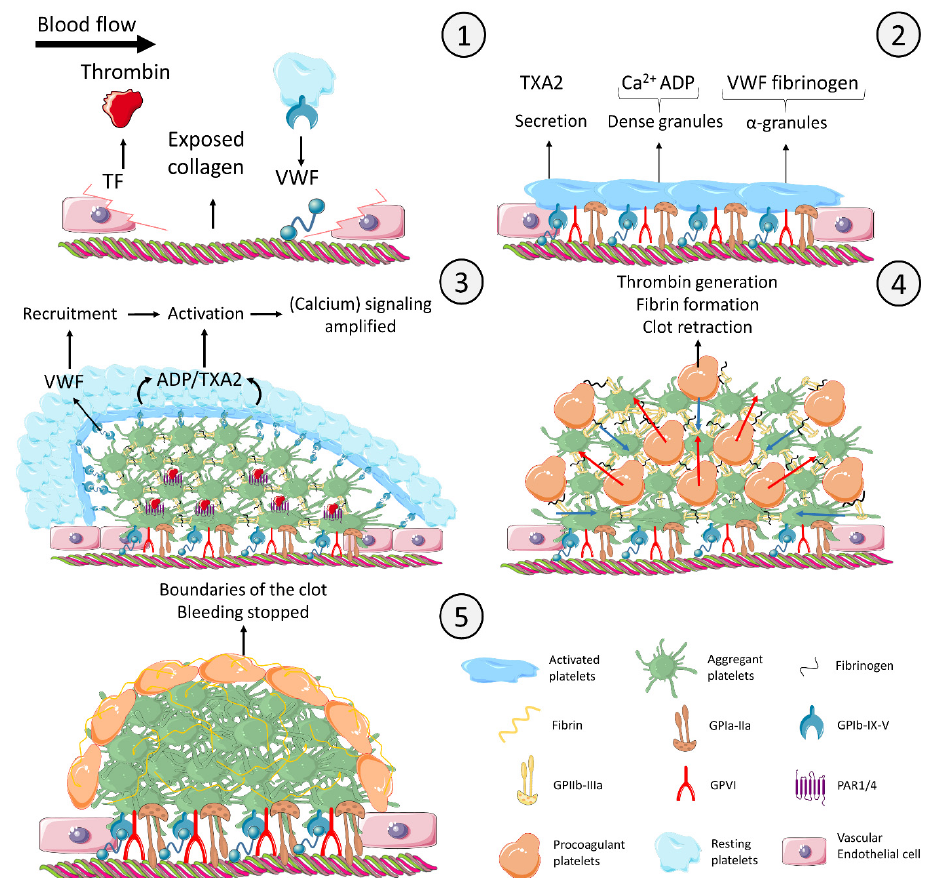
Figure 1. Model of time-and agonist-dependent formation of the thrombus and diversification of platelets at the site of injury. Panel 1. Initiation : The injured endothelial cells express TF and secrete VWF. The subendothelial collagen becomes exposed. Initial thrombin is produced due to TF expres- sion. Platelet GPIb-IX-V complex interacts with the VWF deposited on collagen. Panel 2. Secretion and shape change : Platelets bind to collagen via the receptor GPIa-IIa. Even though GPIb-IX-V and GPIa-IIa trigger intracellular signaling, platelet activation is mainly mediated by the collagen receptor GPVI. Activated platelets synthesize and secrete TXA2. Dense granules containing Ca 2+ and ADP and α -granules containing VWF and fibrinogen are secreted. Panel 3. Aggregation and endoluminal thrombus growth : Platelets aggregate by means of fibrinogen bridging activated GPIIb-IIIa receptors (integrin α IIb β 3). Secreted TXA2 and ADP activate platelets that are recruited into the growing throm- bus by VWF secreted from α -granules. Initial thrombin generation in combination with collagen further activates platelets in the thrombus core. Panel 4. Procoagulant platelets : As the thrombus is growing and the platelets become more and more activated, the increasing cytosolic level of calcium eventually creates procoagulant platelets. Procoagulant platelets downregulate their GPIIb-IIIa re- ceptor, are coated with fibrinogen and other adhesive proteins to be retained in the thrombus, and express negatively charged phospholipids binding coagulation complexes, which localize and en- hance thrombin generation. Thrombin converts fibrinogen into fibrin, which consolidates the platelet clot. In parallel, the outside-in signaling of aggregating platelets inducing clot retraction (blue arrows) squeezes procoagulant platelets out of core of the thrombus (red arrows). Panel 5. Termination : The final configuration completely stops the bleeding and defines the boundaries of the clot to avoid any undesired expansion. The figure uses modified images from Servier Medical Art under a Creative Commons Attribution 3.0 Unported License (http://smart.servier.com, accessed on 31 January 2021). This figure is inspired from [14–18]. Legend: ADP: adenosine diphosphate; Ca 2+ : calcium; GP: glycoprotein; PAR: protease activated receptor; TF: tissue factor; TXA2: thromboxane A2; VWF: von Willebrand